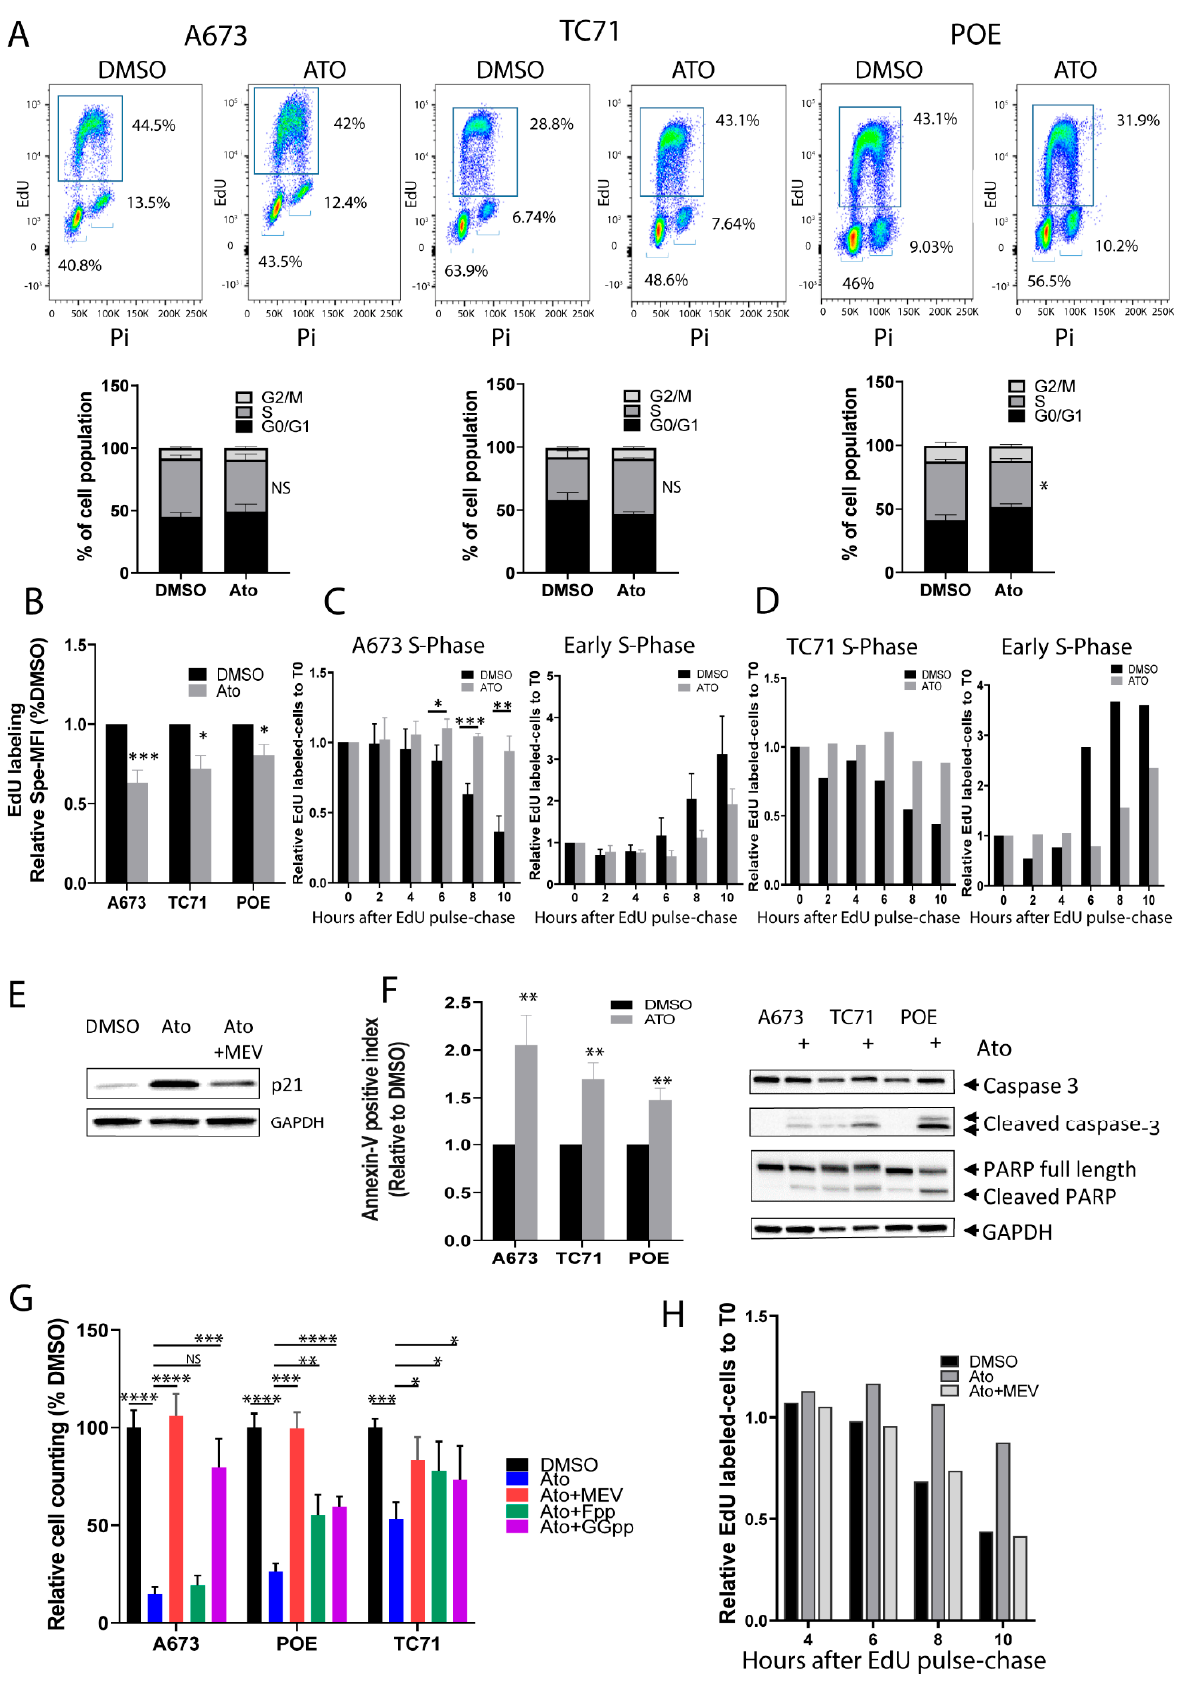
Figure 4. Atorvastatin induces an MVA pathway-dependent slowdown of the S-phase of cell cycle and apoptosis. ( A ) Analysis of cell cycle by EdU staining in A673 (n = 3 biological replicates), TC71